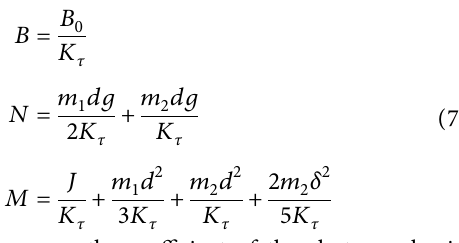
Figure 3: The comparison of tracking errors PC and AC with y